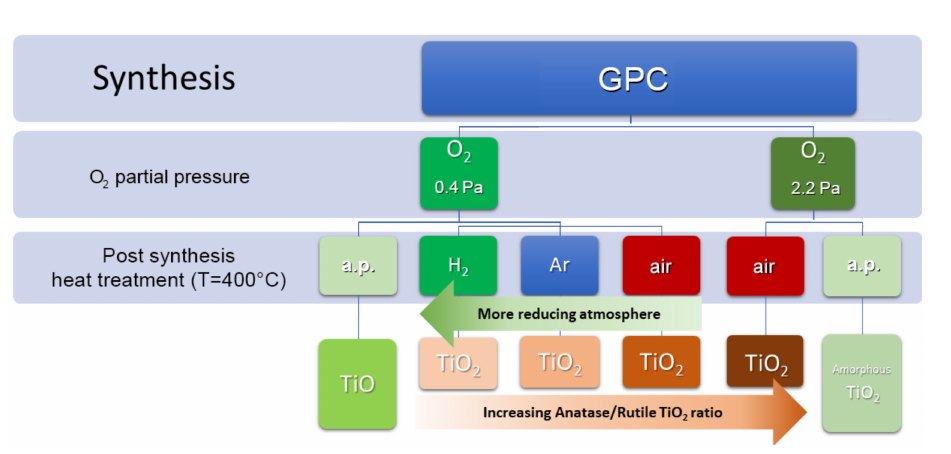
Figure 2. Schematics of the phases identified in TiO x NPs as a function of the conditions applied during synthesis by GPC and successive thermal